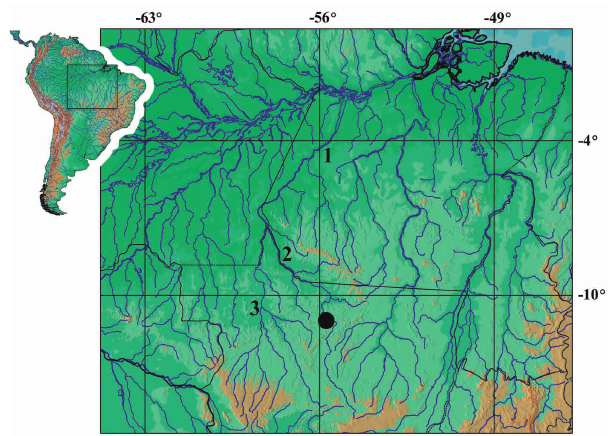
Fig. 3. Map of southeastern Amazon basin showing location of type locality of Gelanoglanis pan , 1 = rio Tapajós, 2 = rio Teles Pires, 3 = rio Juruena